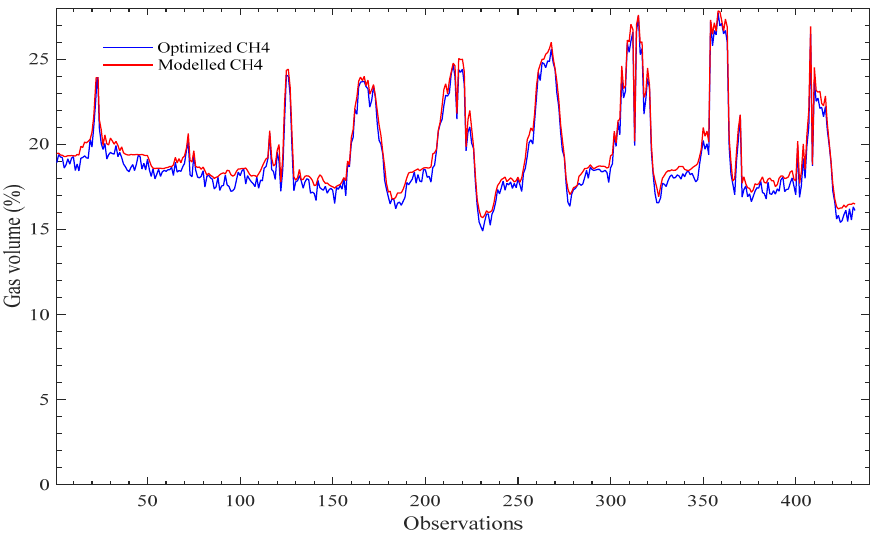
Figure 3. Modelled and optimized methane volume for the biogas digester.